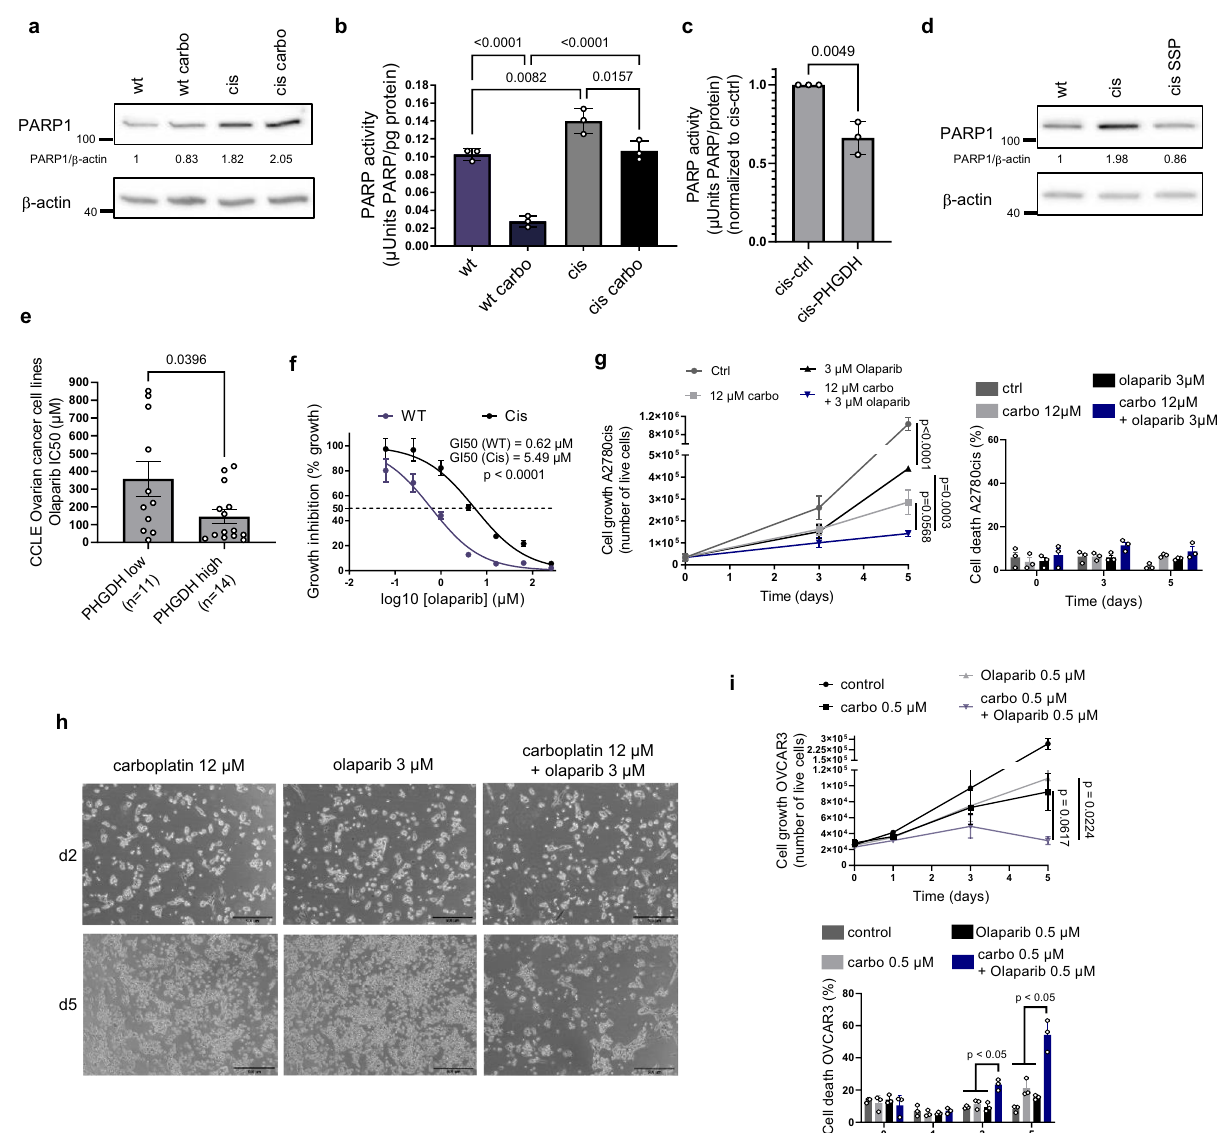
Fig. 6 | Resistant cells with decreased serine synthesis sustain PARP activity under carboplatin treatment. a Western blot of PARP1 in wt and cis cells, n =4 biologicalreplicates. PARP activity in carboplatin treatedwtand cis cells( b ) and in cis-PHGDHoverexpressingcells( c ), n =3biologicalreplicates(withthreetechnical replicates each),ordinary one-wayANOVAwith Tukey ’ s multiplecomparisonpost- test, data are represented as mean±SD with p <0.0001 ( b ) and n =3 biological replicates(withthreetechnicalreplicateseach),unpairedtwo-tailed t -test,dataare represented as mean±SD, p =0.0049 c . d Western blot of PARP1 in cis SSP cells, n =2 biological replicates. e Olaparib sensitivity of PHGDH low and PHGDH high expressingovariancancercelllines,dataobtainedfromtheCCLE(geneexpression) andGDSC(drugsensitivity), n =25dividedinPHGDH low (PHGDHmRNA Z <0, n =11) and PHGDH high (PHGDH mRNA Z >0, n =14) subgroups, unpaired two-tailed t -test, error bars represent SEM, p =0.0396. f GI50 value of wt and cis cells for the PARP inhibitor olaparib, n =3 biological replicates (with three technical replicates each),